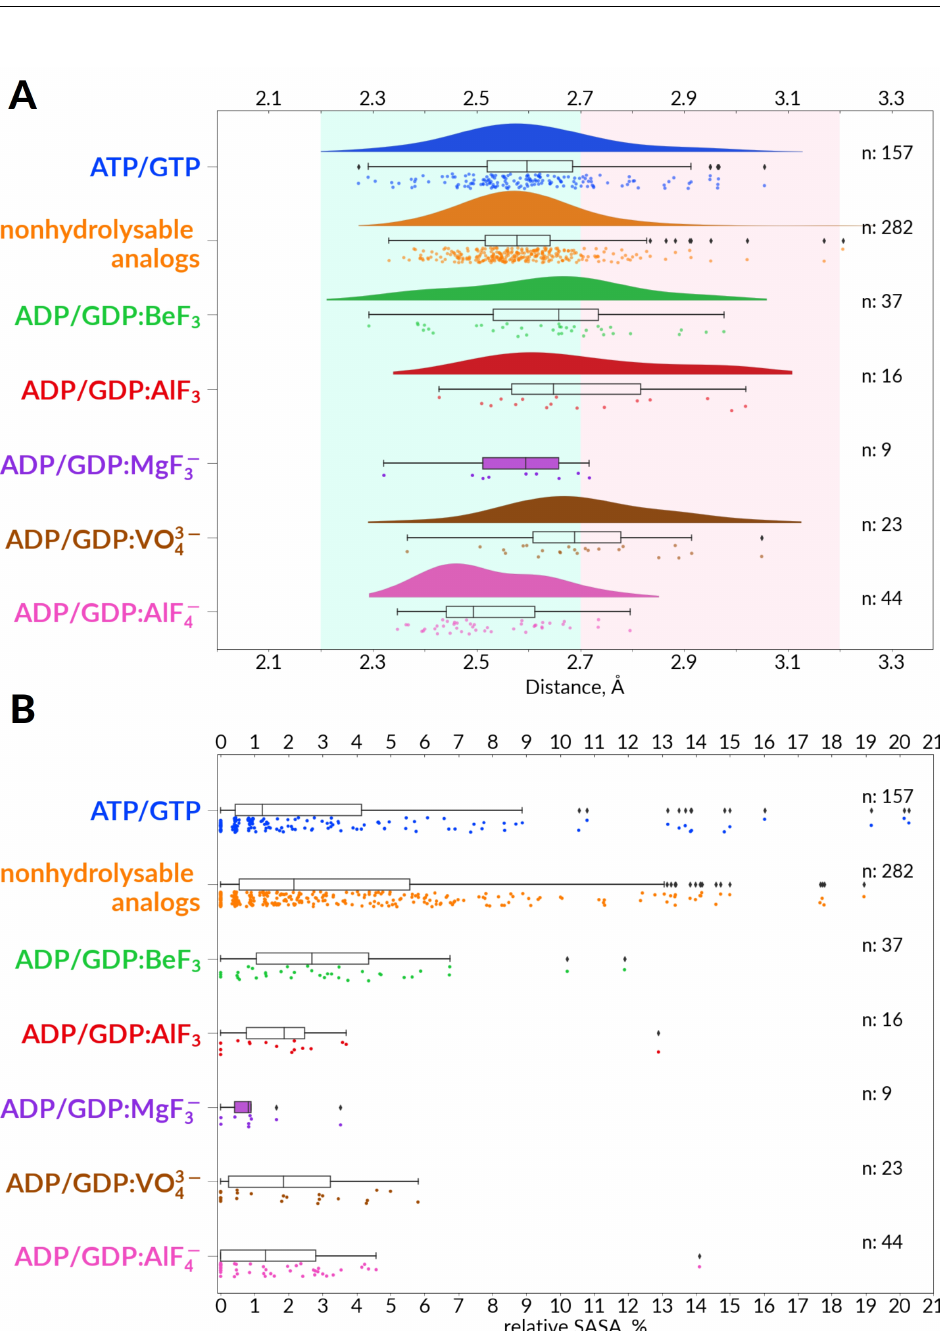
Figure 8. Properties of Asp WB residues in high-quality in P-loop NTPase structures with bound Mg-NTP molecules or their analogues (resolution threshold 2.5 Å; see Table S1 for the entire data set). ( A ) Distances between the side chains of [Asp] WB and [Ser/Thr] K+1 . For each type of complexes, distances are visualized as a kernel density estimate (KDE) plot, a boxplot and individual data points, each point representing one catalytic site in one structure. For ADP/GDP:MgF 3 − complexes the density plot is not shown owing to the scarcity of data. The range of short H-bonds (2.2–2.7 Å) is highlighted in cyan, and the typical H-bond range (2.7–3.2 Å) is highlighted in pale pink. ( B ) Relative solvent-accessible surface area (SASA) values for Asp WB residues. The calculated SASA values are shown for the same catalytic sites as on panel 8 ( A